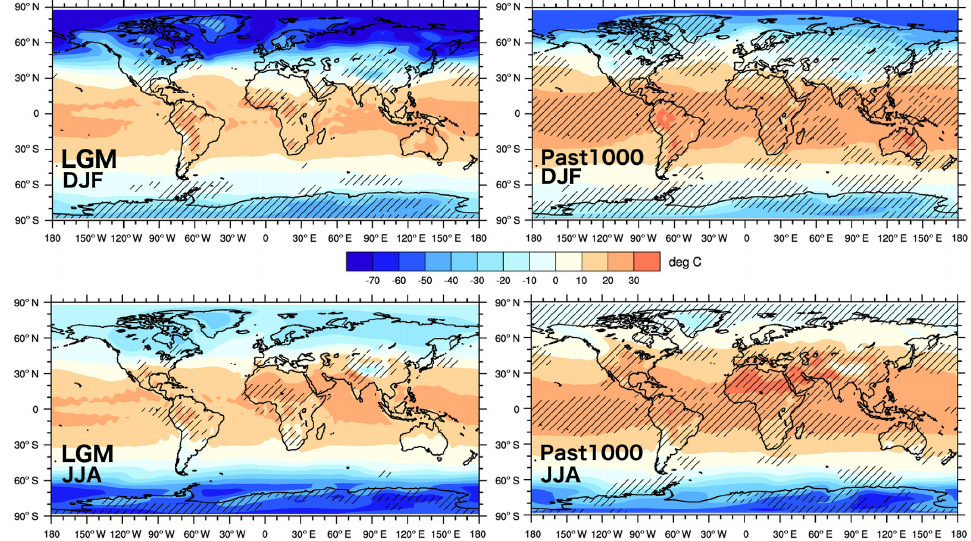
Figure 2. 2m temperatures averaged over all PlaSim ensemble members for indicated seasons and periods. Hatching indicates where the PlaSim ensemble average values lie within the range of CMIP5 models.